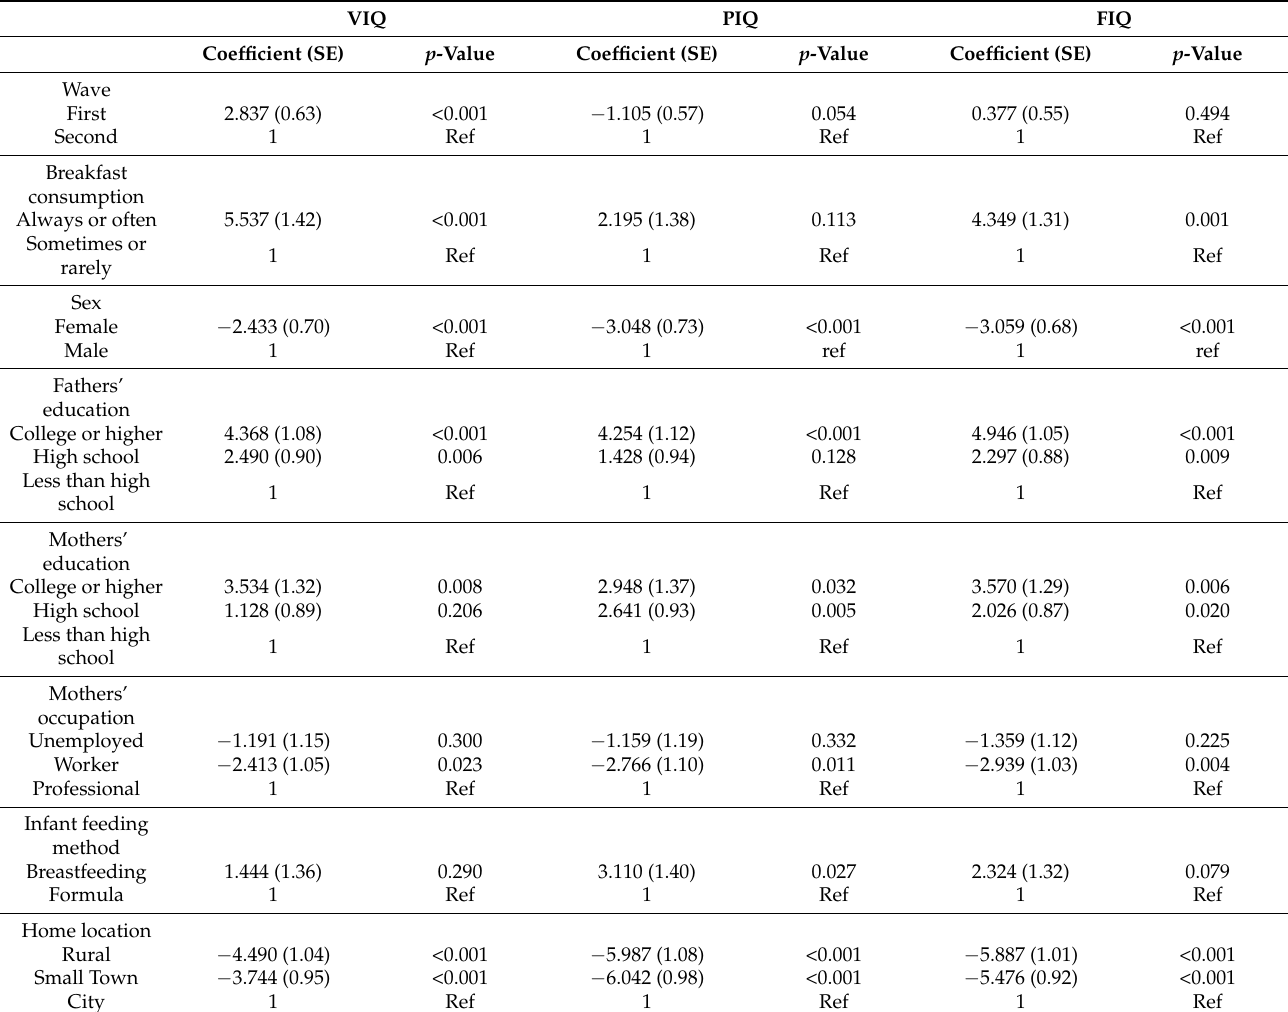
Table 2. Longitudinal analysis of multivariable mixed model: association between repeatedly measured IQ and breakfast consumption frequency ( n =